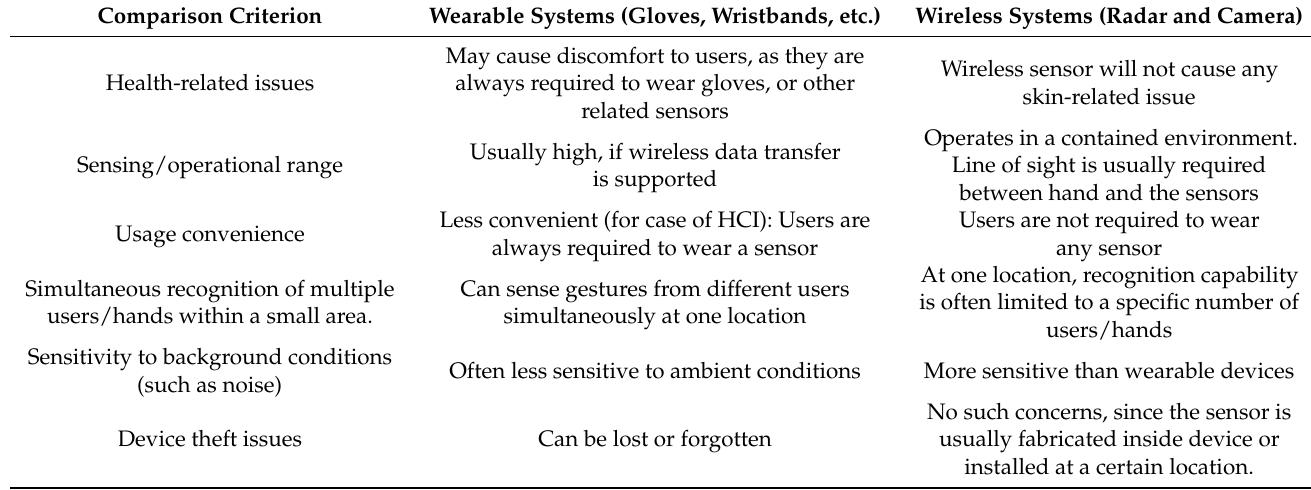
Table 1. Comparison of wearable and non-wearable (wireless) sensors for sensing and measuring hand gestures. Comparison